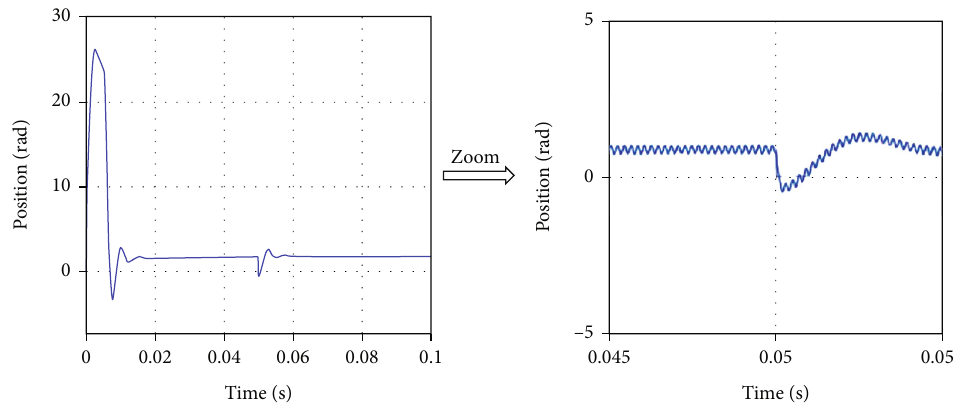
Figure 24: Speed estimation error using the LO.